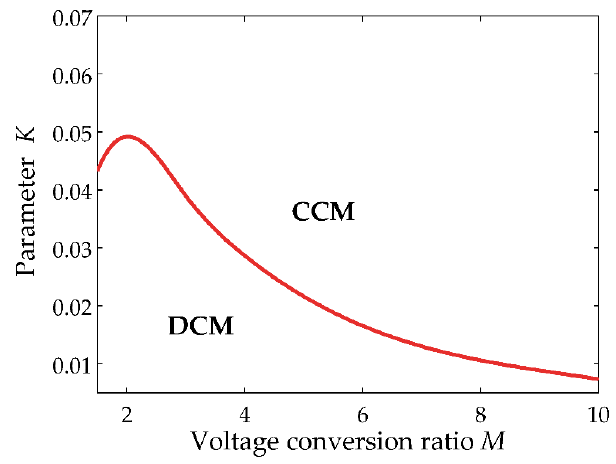
Figure 6. The operation boundary between DCM and CCM.